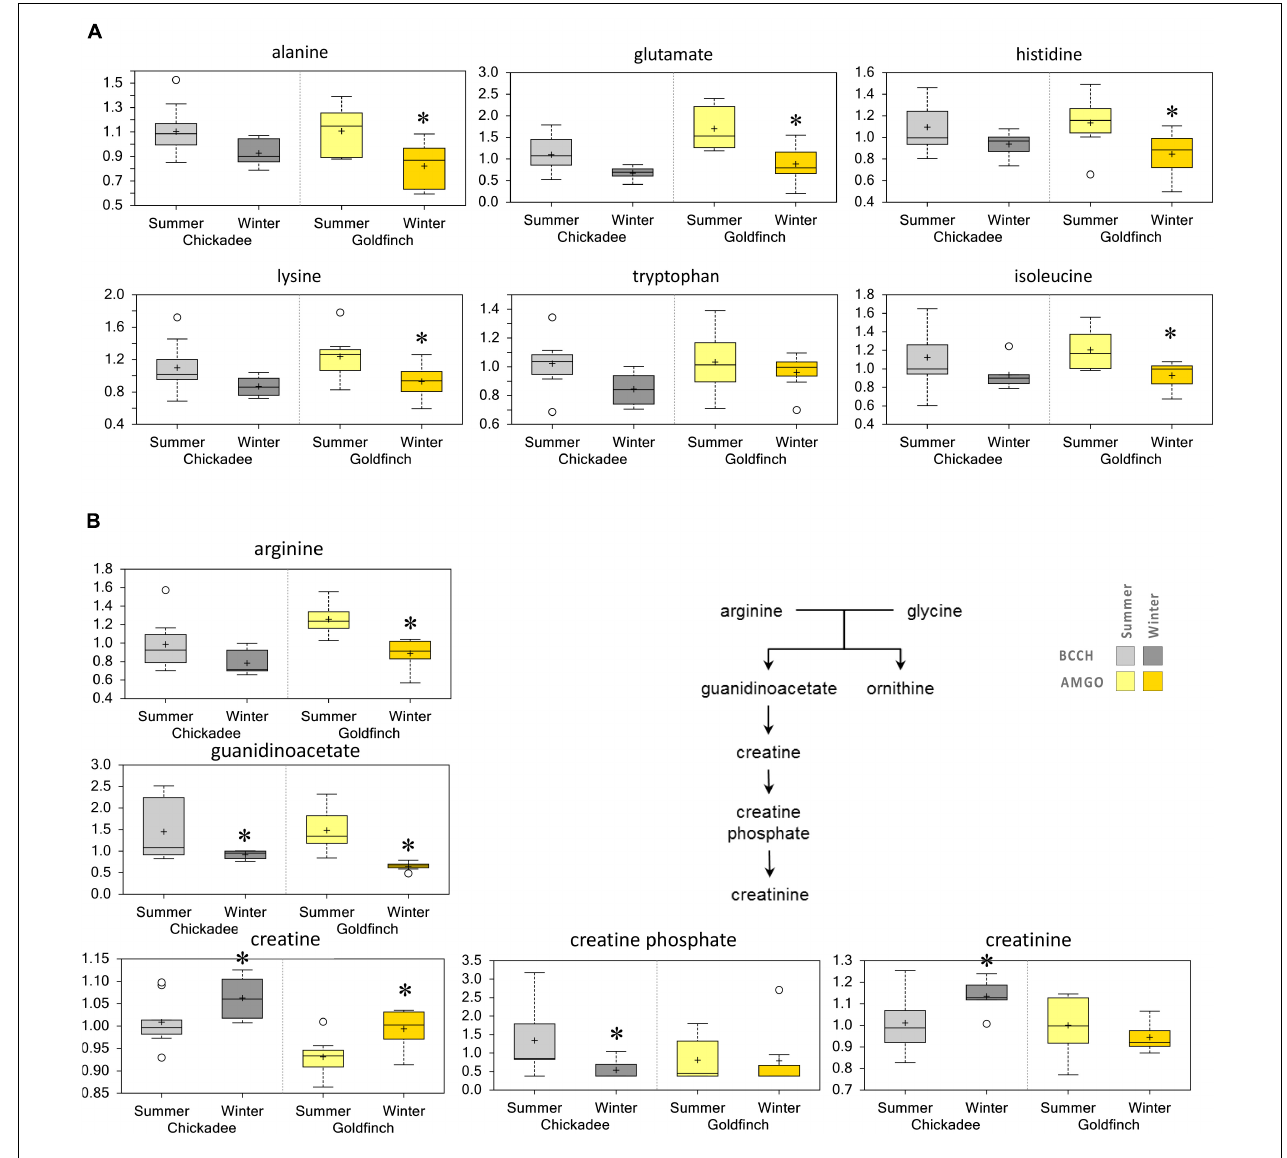
FIGURE 3 | Differences in the abundances of (A) amino acids and (B) amino acid derivatives in pectoralis muscle of Black-Capped Chickadee (BCCH) and American Goldfinch (AMGO). The X -axis represents the species and the seasons sampled. The Y -axis box plots indicate the scaled intensity mean (+) and median (–) values: upper and lower ranges of boxes indicate upper and lower quartiles, respectively; upper and lower whiskers indicate the maximum and minimum distributions of the data; small circles represent outlying data points. ∗ Significantly ( p < 0.05 and q < 0.10) different compared to the other season within the